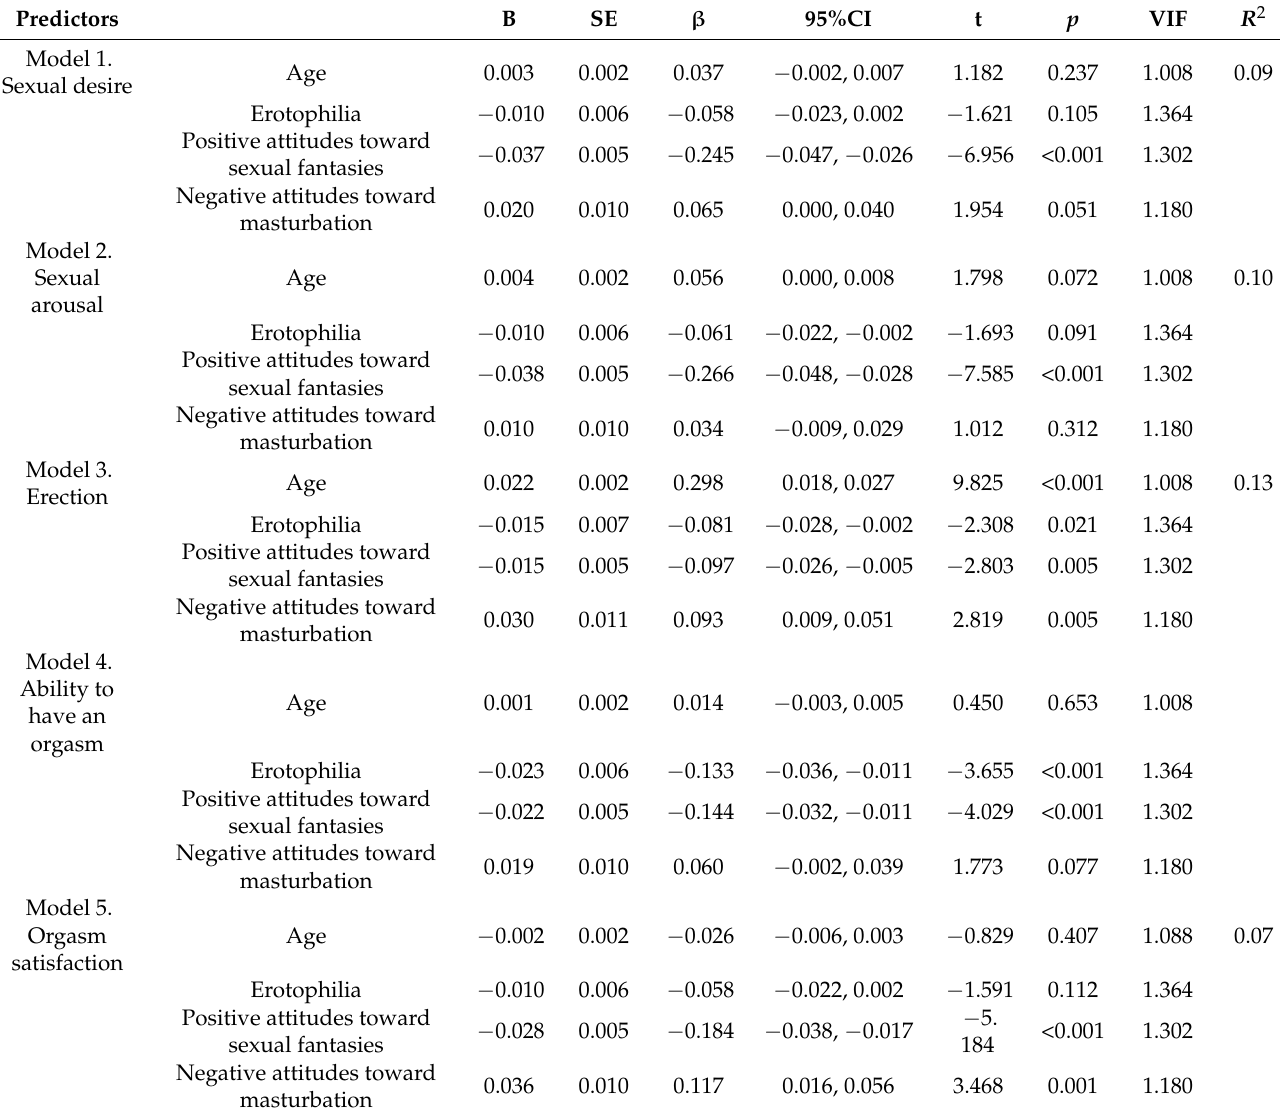
Table 4. Hierarchical regression for sexual function in